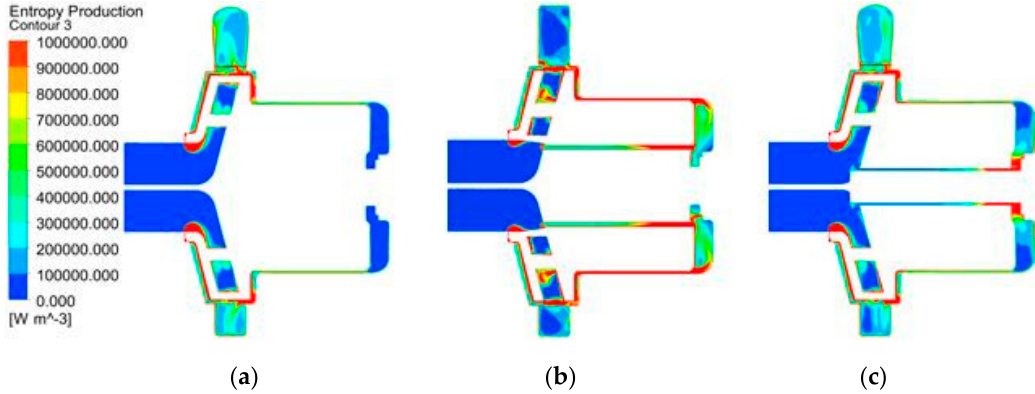
Figure 10. Comparison of the entropy production on the X – Z plane of the pump without balancing holes and the pumps with six Type A and B balancing holes of 4 mm diameter: ( a ) without balancing holes; ( b ) with Type A balancing holes; ( c ) with Type B balancing holes.